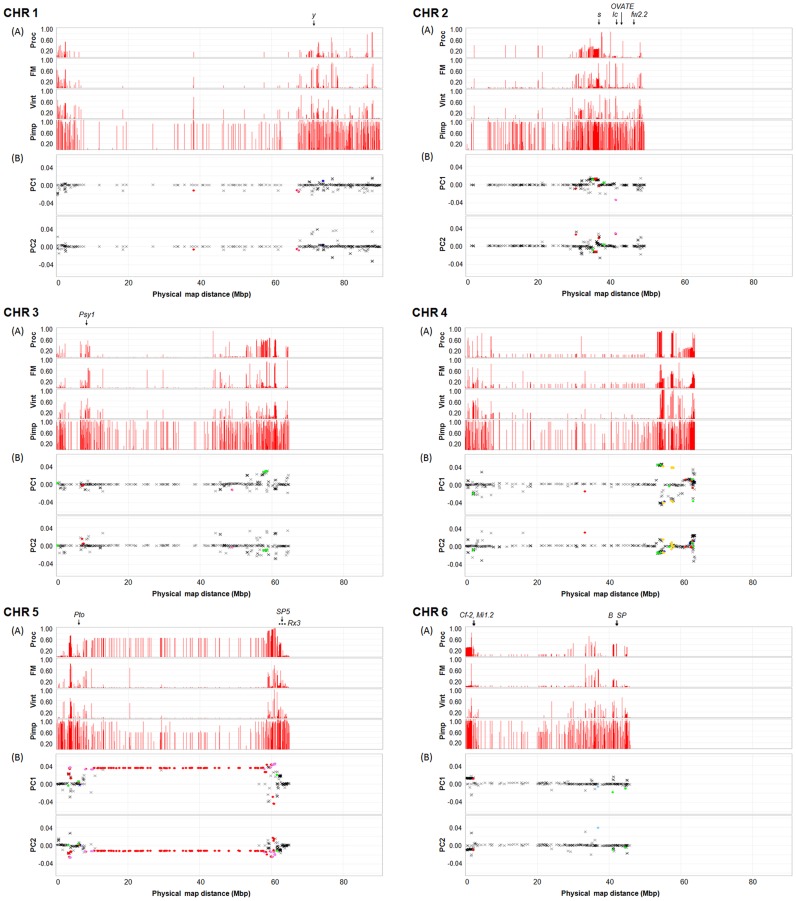
Minor allele frequency (MAF) patterns, PCA loadings, and F
st outliers on chromosomes 1 to 6.The minor allele was determined relative to allele calls for all 410 inbred accessions based on 7,310 SNPs, and then MAF was estimated and graphed for processing (Proc), fresh market (FM), and vintage (Vint) and S. pimpinellifolium (Pimp) sub-populations (A). The 28 tomato genes listed in Table S9 are positioned based on their coding sequences (arrow) and flanking markers (dotted line). The Y-axis represents allele frequency and the X-axis represents physical positions of the SNPs oriented with respect to the tomato genome sequence [102]. PCA loadings for PC 1 and PC 2 are graphed with candidates for loci under positive selection based on F
st outlier analysis [27], [28] (B). The candidate loci are indicated by dots (•) with a color scheme indicating pairwise comparisons that were significant: red for Proc vs. FM; green for Vint vs. Proc; blue for Vint vs. FM; violet for Proc vs. FM and Vint; sky blue for FM vs. Proc and Vint; and gold for Vint vs. Proc and FM. All other loci are indicated by X (black).